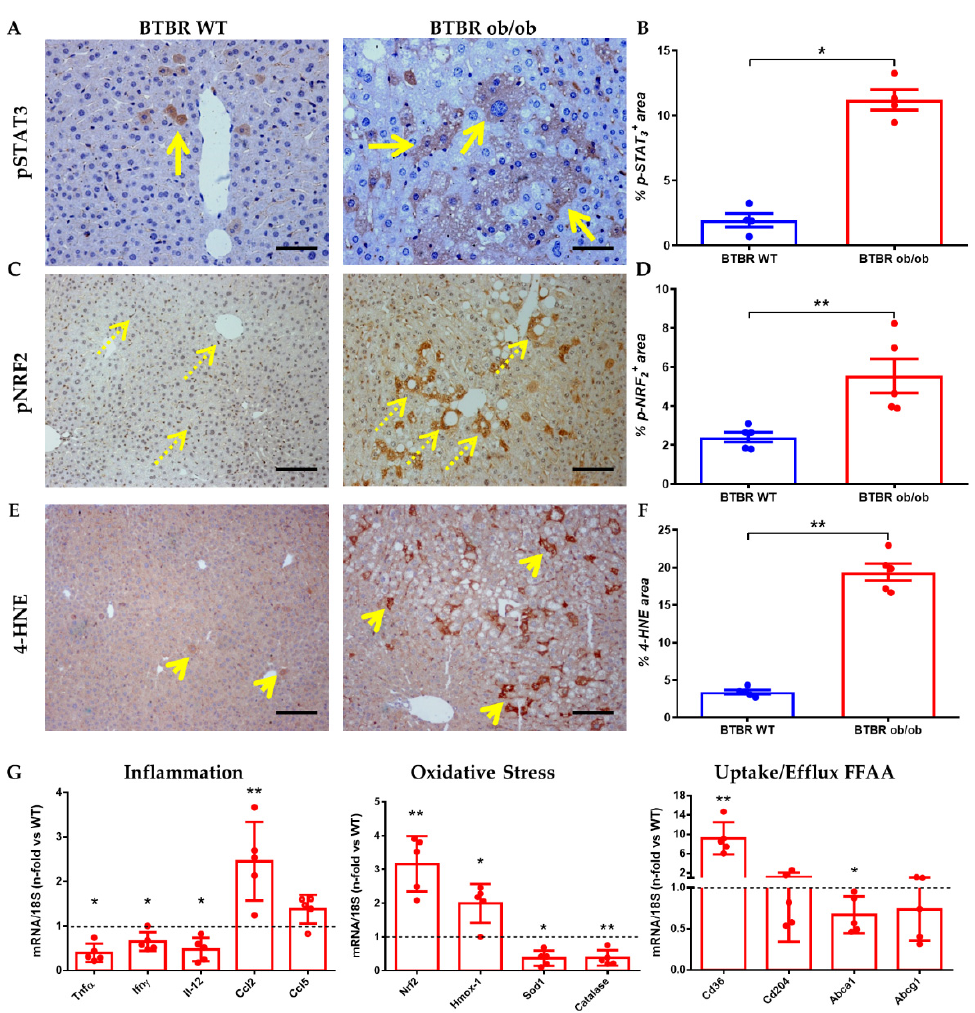
Figure 3 . Comparison of inflammatory, oxidative stress and lipid markers between BTBR WT (left) and BTBR ob/ob (right) at 12 weeks . ( A ) Representative image of pSTAT3 (long arrow) immunostaining (magnification 200×) and ( B ) pSTAT3 activation quantification. ( C ) pNRF2 staining (dotted arrow) as oxidative stress response (magnification 100×) and area quantification ( D ). ( E ) 4-HNE staining (short arrow) as lipoperoxidation (magnification 100×) and its quantification ( F ). In the lower row ( G ) is shown mRNA expression of several inflammation (Tnf α , Ifn γ , Il-12, Ccl2 and Ccl5); oxidative stress (Nrf2, Hmox-1, Sod-1 and Catalase) and lipid uptake/efflux (CD36, CD204, ABCa1 and ABCg1) genes. Data are shown as scatter dot plots and mean ± SEM of each group ( n = 5 mice/group); * p < 0.05, ** p < 0.01, vs. BTBR WT.